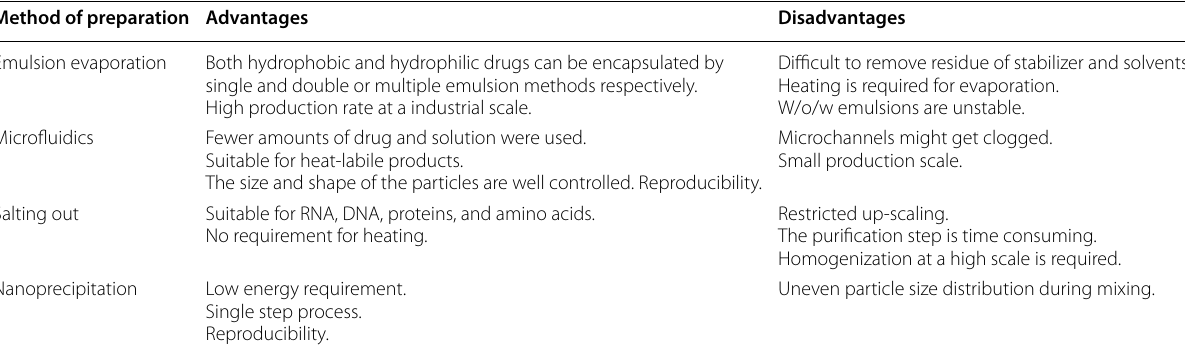
Method of preparation